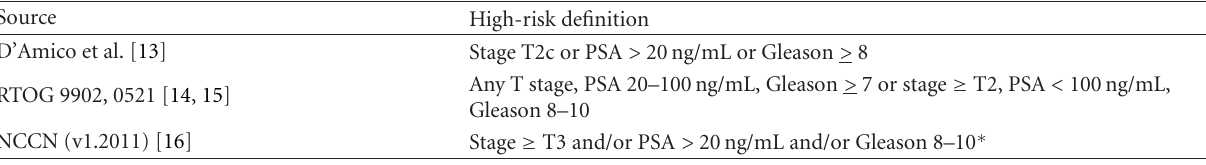
Table 3: Risk stratification for high-risk prostate